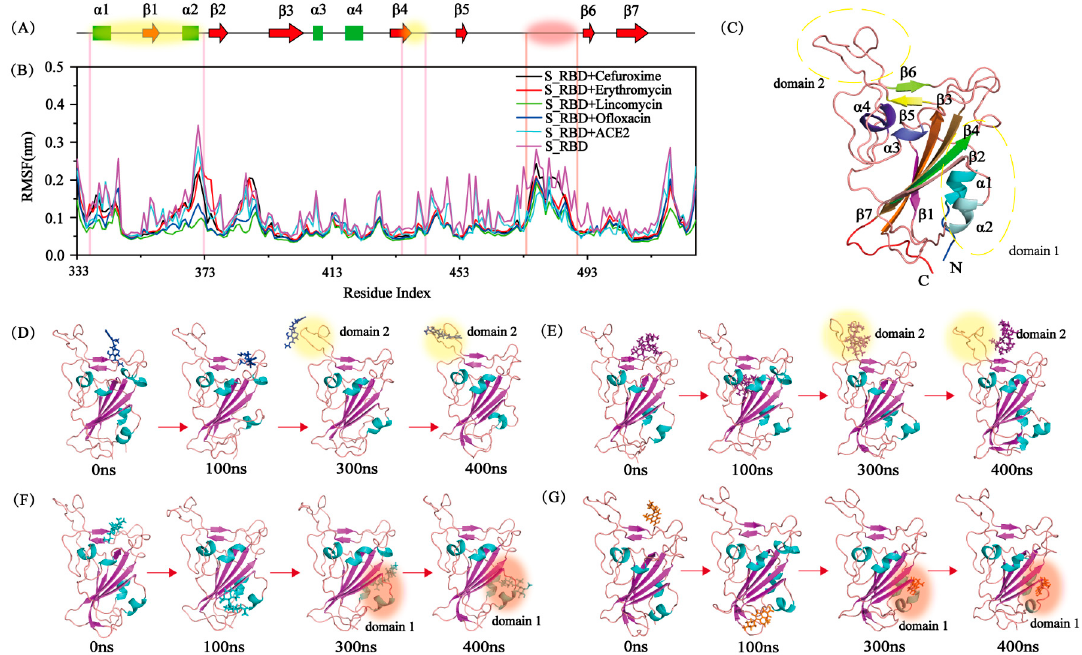
Figure 2. The flexibility of S_RBD residues in the six systems and conformational change of protein in the presence of inhibitors. ( A ) The sequence of the protein S_RBD (PDB ID: 6LZG). The strands are represented by red arrows and helices are shown as green cylinders in the sequence. The domain 1 is a yellowish background, and the domain 2 is red background. ( B )The analysis of the average RMSFs of S_RBD in the S_RBD in the presence of ACE2 system, the S_RBD protein system and the four complex systems. ( C ) The 3D structure of S_RBD in the new cartoon representation. N terminal (blue) and C terminal (red). The snapshots at 0 ns, 100 ns, 300 ns and 400 ns, respectively for the ( D ) S_RBD with Cefuroxime (blue) system, ( E ) S_RBD with Erythromycin (purple) system, ( F ) S_RBD with Lincomycin (cyan) system, and ( G ) S_RBD with Ofloxacin (orange) system.